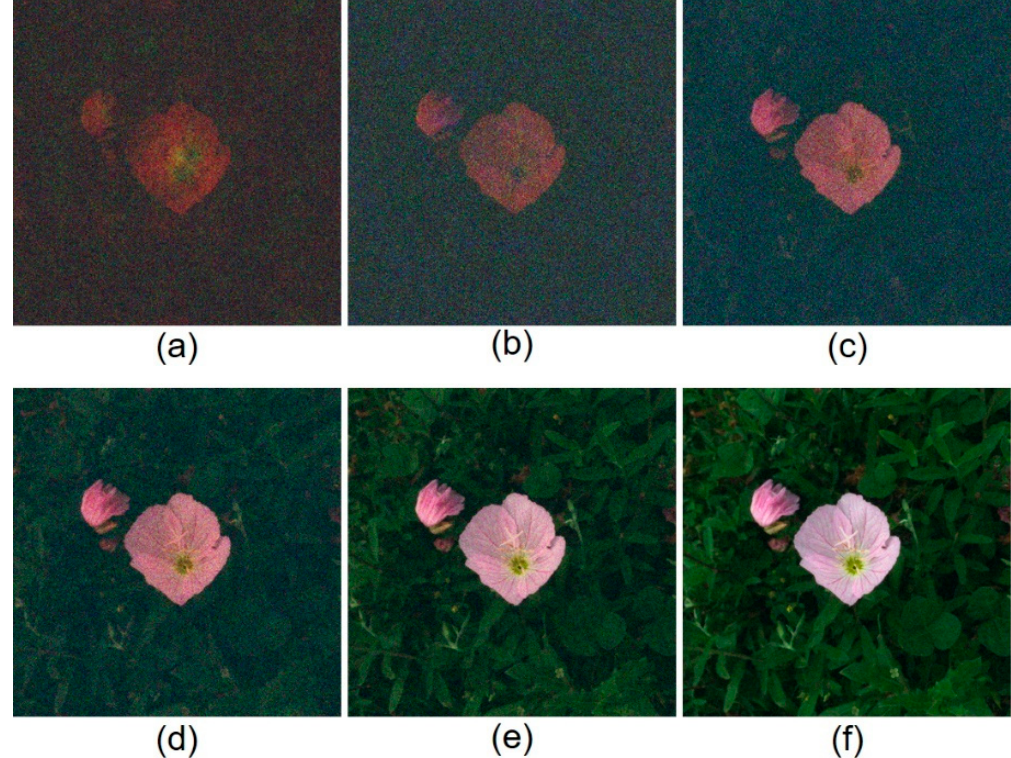
Figure 4. Numerical results: Reconstructed images when bit depths of holograms are ( a ) 2, ( b ) 3, ( c ) 4, ( d ) 5, ( e ) 6, and ( f ) 7 bits.